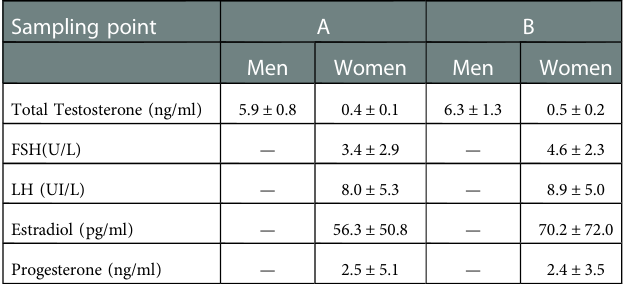
TABLE 1 Levels of sexual hormones in athletes at both sampling points.